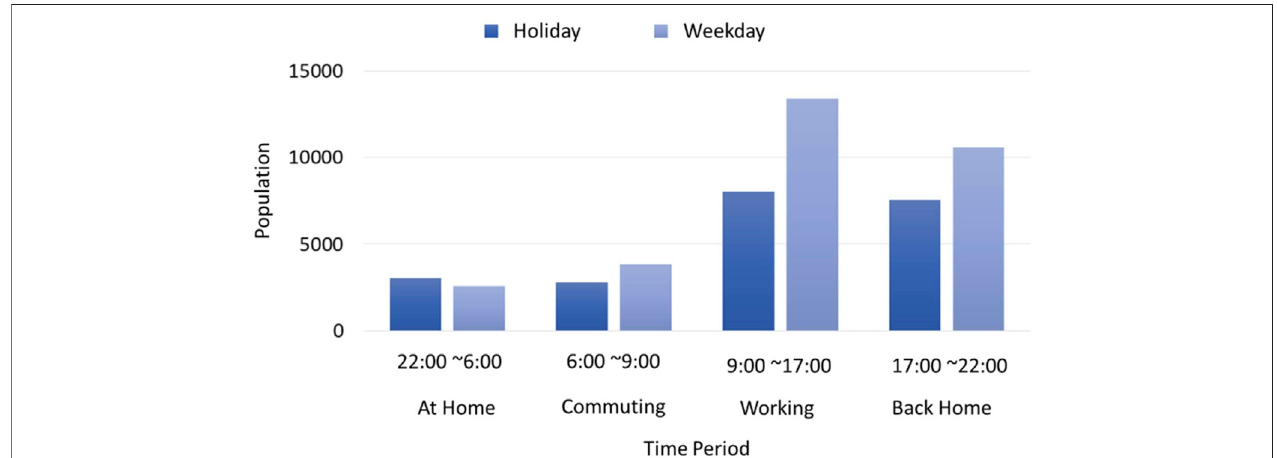
FIGURE 20 | Population near Taipei Main Station at different times on weekdays and holidays.